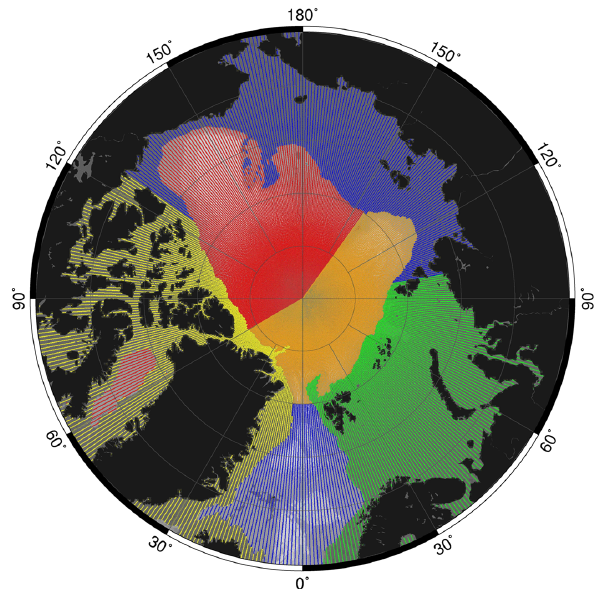
Figure 6. Regions that were used for the statistical screening (see Sect. 3). Red: Amerasian Basin. Light red: deep basin of Baffin Bay. Blue: Amerasian shelf. Light blue: Greenland–Iceland–Norwegian seas. Orange: Eurasian Basin. Green: Barents and Kara seas. Yel- low: Canadian Archipelago and Greenland–Iceland